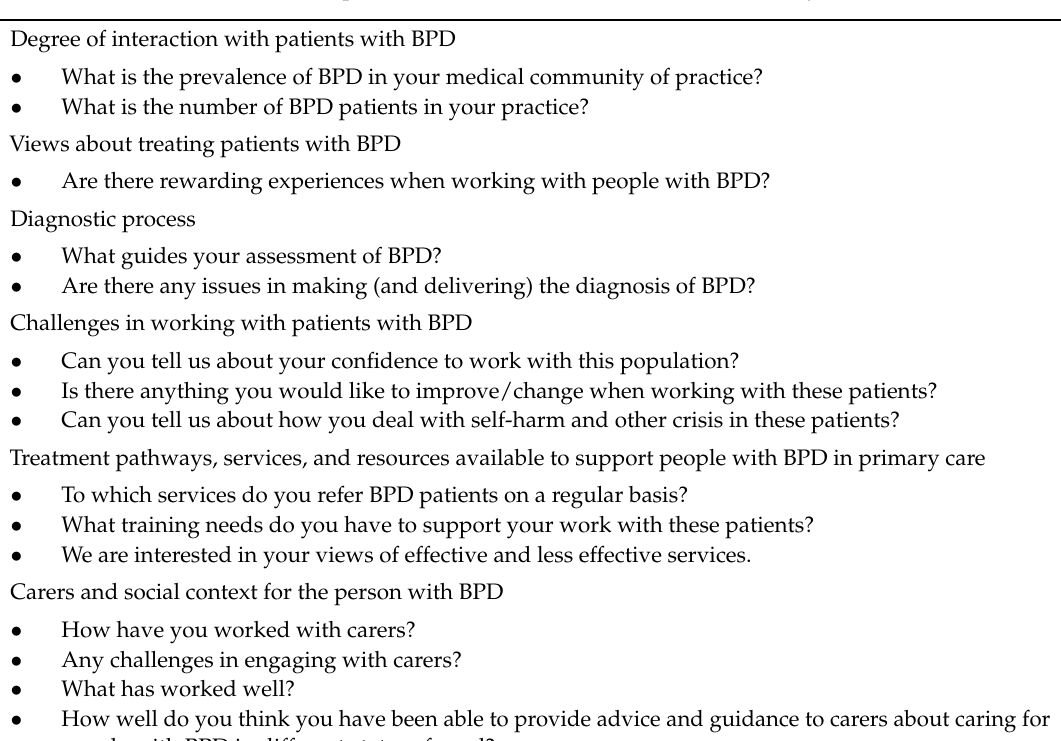
Table 1. Focus Group Guide Questions. BPD: Borderline Personality